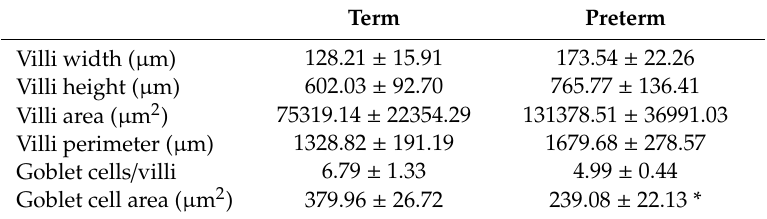
Table 3. Histomorphometric variables of small intestine: villi width, height, area, perimeter and the number of goblet/villi and their cellular area from term and preterm groups at day 10 of suckling period.